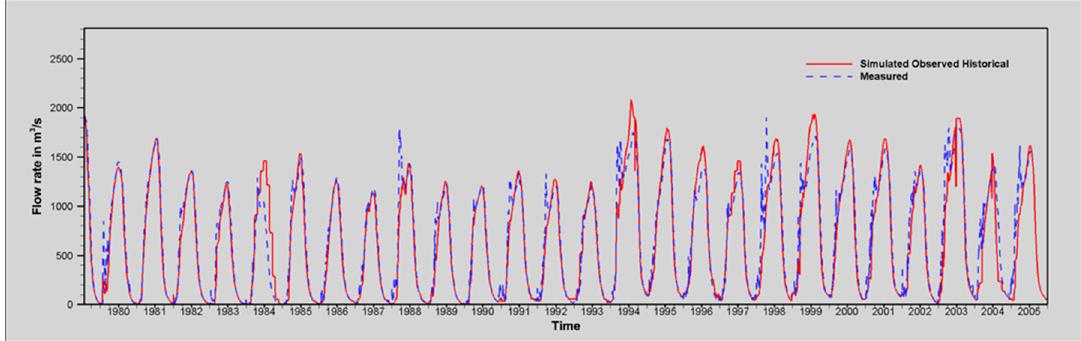
Figure 8. Validation of simulated historical surface water flow rates against measurements.